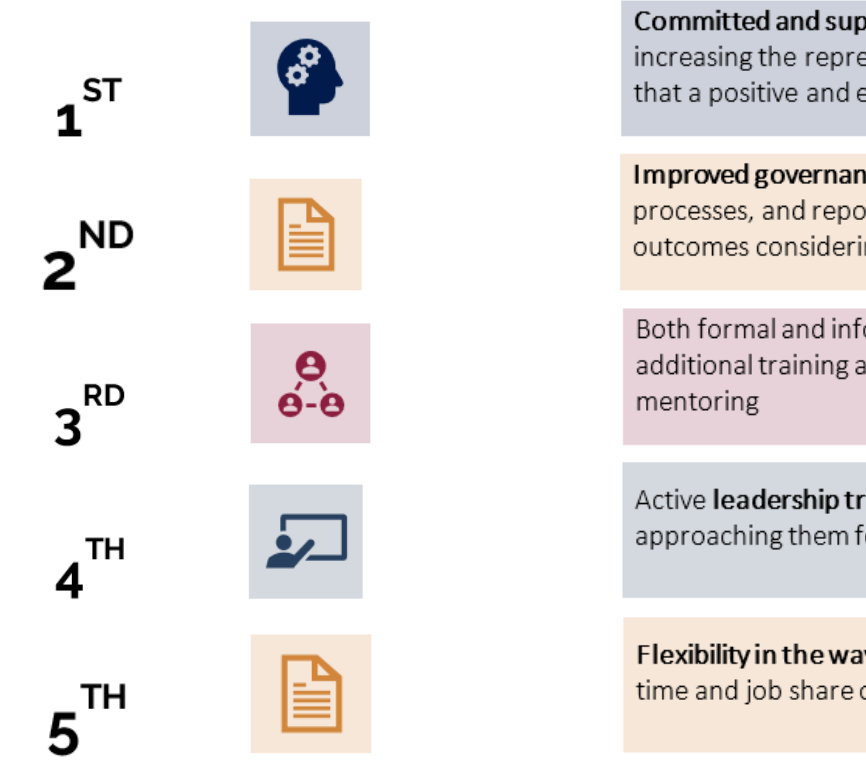
Table 2. Descriptions of prioritised interventions based on feasibility of interventions, in order of importance.